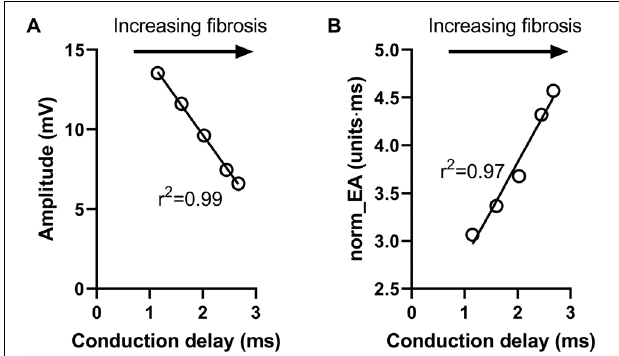
FIGURE 7 | Influence of simulated fibrosis on bipolar electrogram morphology in a model of a propagating mouse action potential (analysis). Quantitative analysis of the relationship between conduction delay and electrogram morphology in conditions of varying levels of tissue fibrosis (electrogram recorded within fibrotic tissue). (A) Bipolar electrogram amplitude, (B) normalized electrogram area